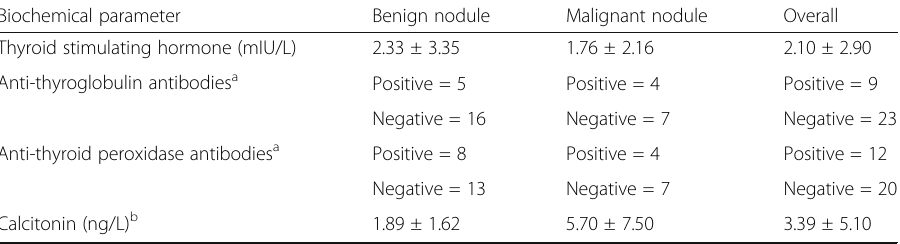
Table 3 Summary of biochemical data Biochemical parameter Benign nodule